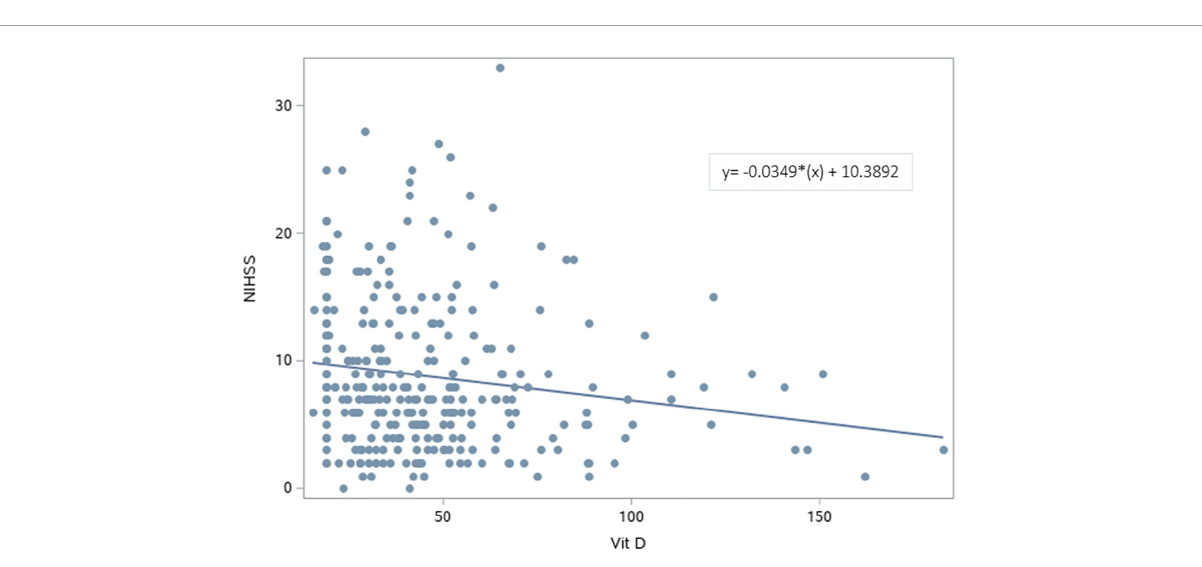
FIGURE2 Scatterplot of the National Institutes of Health Stroke Scale vs. Vitamin D levels. A significant regression equation predicting NIHSS score based on vitamin D level was found ( F = 7.44, p = 0.007). Patients predicted NIHSS score is equal to 10.3892–0.0349 (Vitamin D level) measured in nmol/L, with an R 2 of